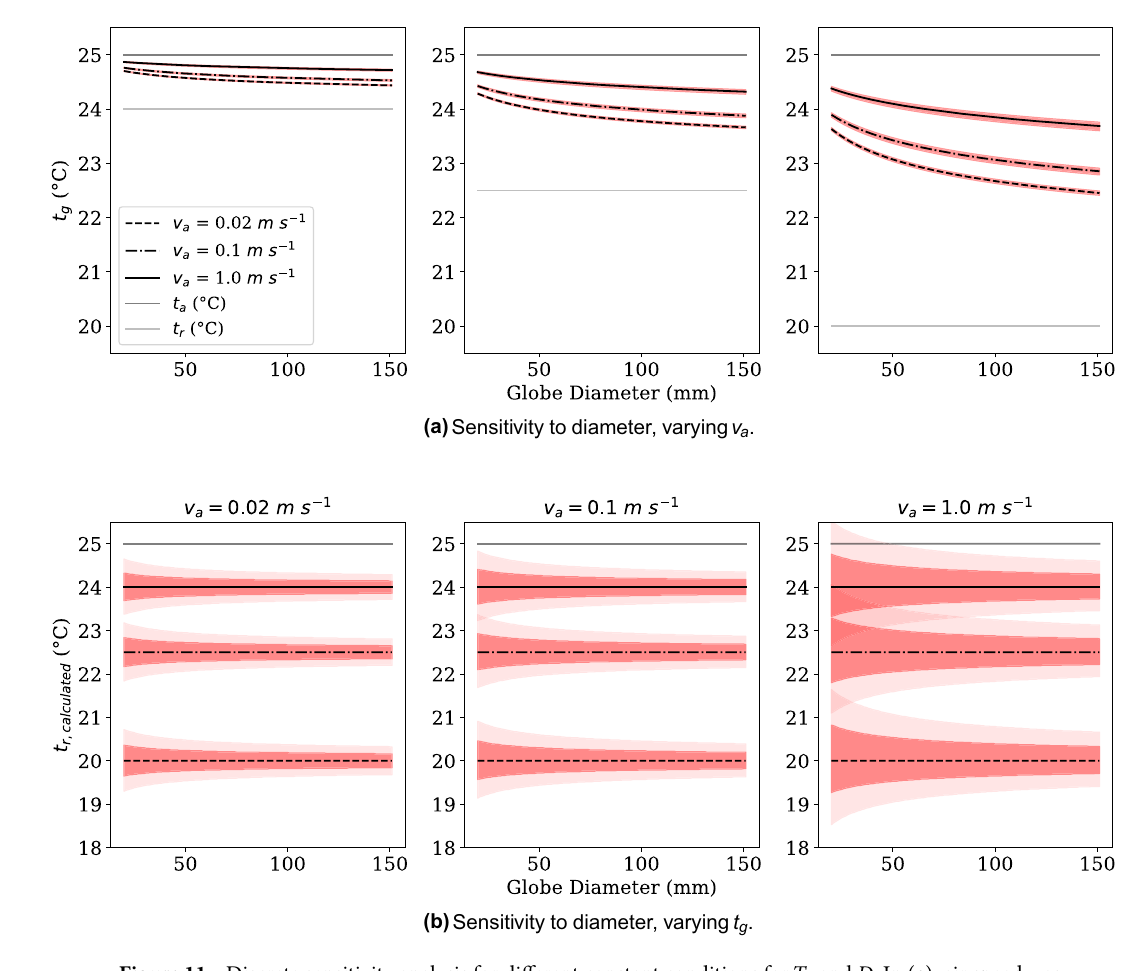
2 to 2 standard −